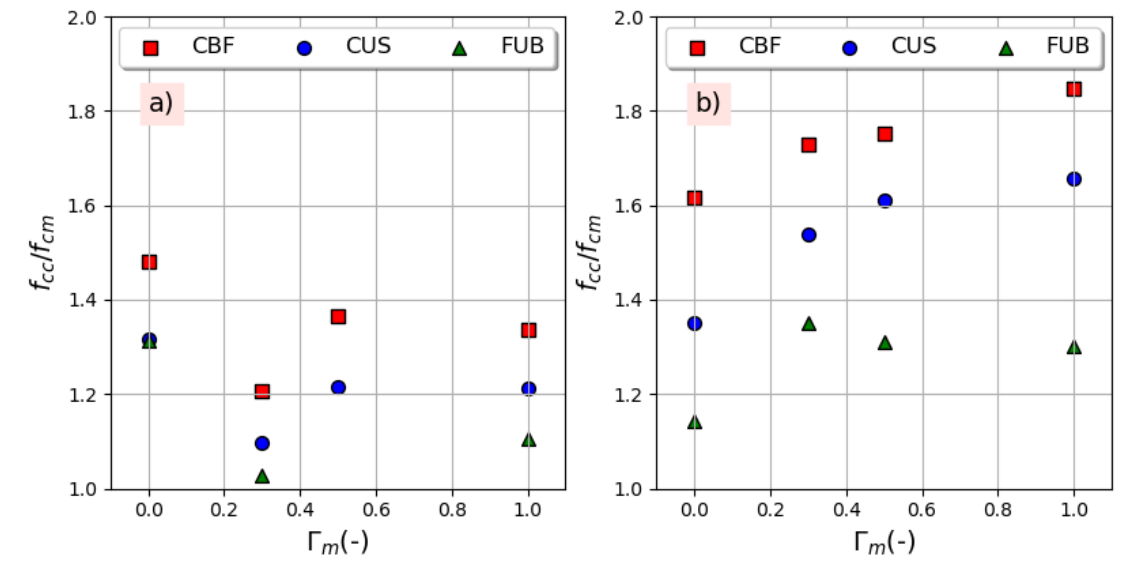
Figure 8. Strength enhancement with replacement ratio: ( a ) without air-entraining agent, ( b ) with 4% air-entraining agent.